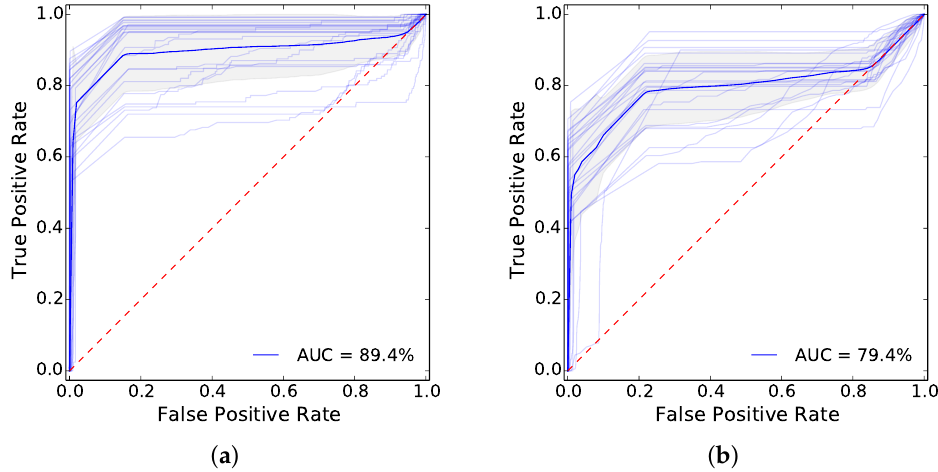
Figure 9. ROC curves regarding the face recognition task considering the ( a ) P1E_S2 and ( b ) P1L_S2 image sequences from all cameras. The figures comprise a mean ROC (blue) curve from all 25 (light blue) class-specific curves, i.e., for each face class in the dataset. These class-specific ROC curves were calculated via a one-versus-all classification procedure.